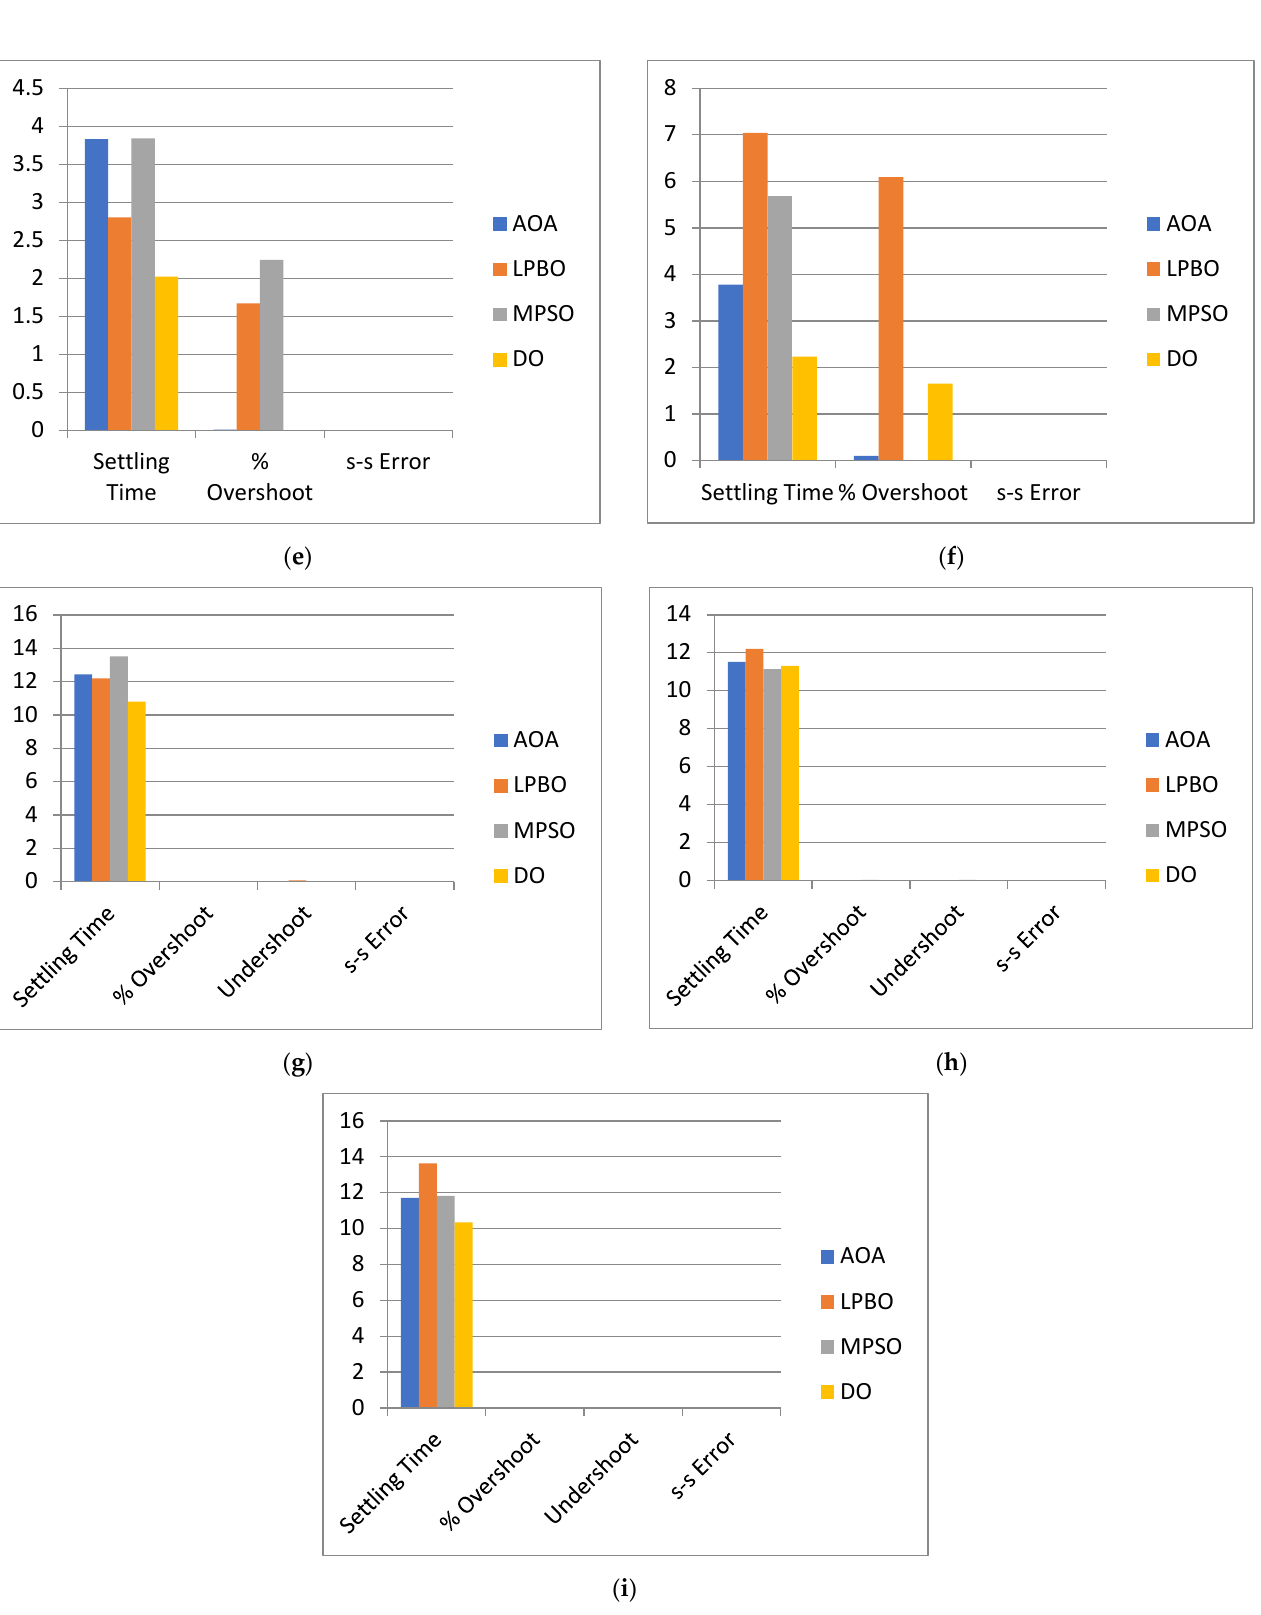
Figure 19. Graphical comparison in a three-area multi-source IPS with nonlinearities. ( a ) ∆ f 1 ; ( b ) ∆ f 2 ; ( c ) ∆ f 3 ; ( d ) V t1 ; ( e ) V t2 ; ( f ) V t3 ; ( g ) ∆ P tie1 ; ( h ) ∆ P tie2 ; ( i ) ∆ P tie3 .